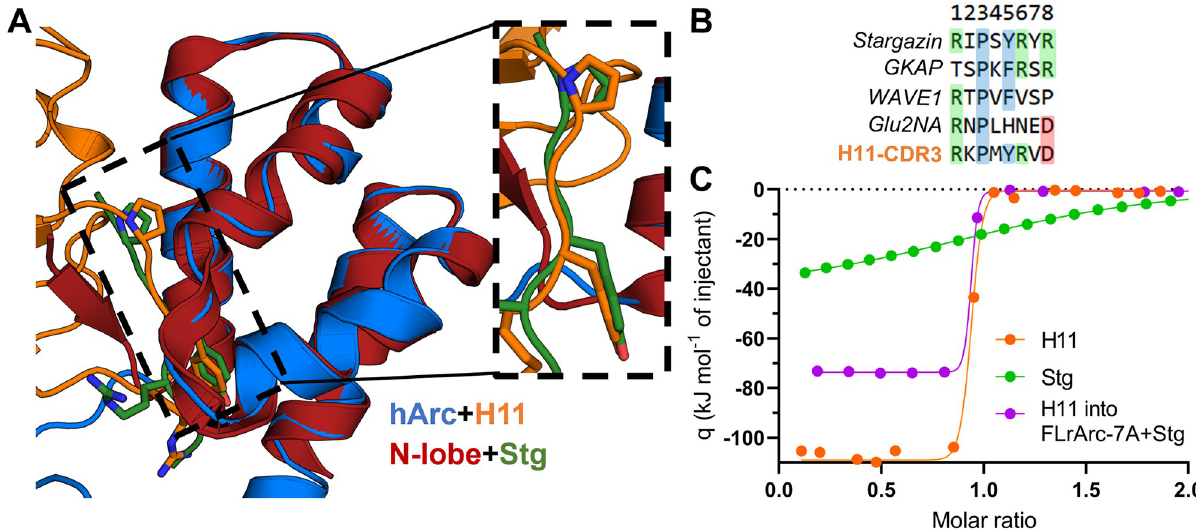
Fig 8. NbArc-H11 as a peptide binding inhibitor. A Alignment of hArc-CTD bound to H11 with the crystal structure of the human N-lobe with bound Stg (6TNP, [34]) reveals the identical mode of binding. B Sequences of various Arc ligand peptides aligned with the sequence of the H11-CDR3. C ITC displacement assay. Shown are the integrated thermograms of H11 and Stg titrated into FLrArc-7A, and H11 titrated into FLrArc-7A bound to Stg. The decreased binding enthalpy of H11 binding to Stg bound FLrArc-7A suggests that H11 binding leads to Stg dissociation. Raw thermograms are shown in S6 Fig. The H11 titration curve is the same as shown in Fig 4B.